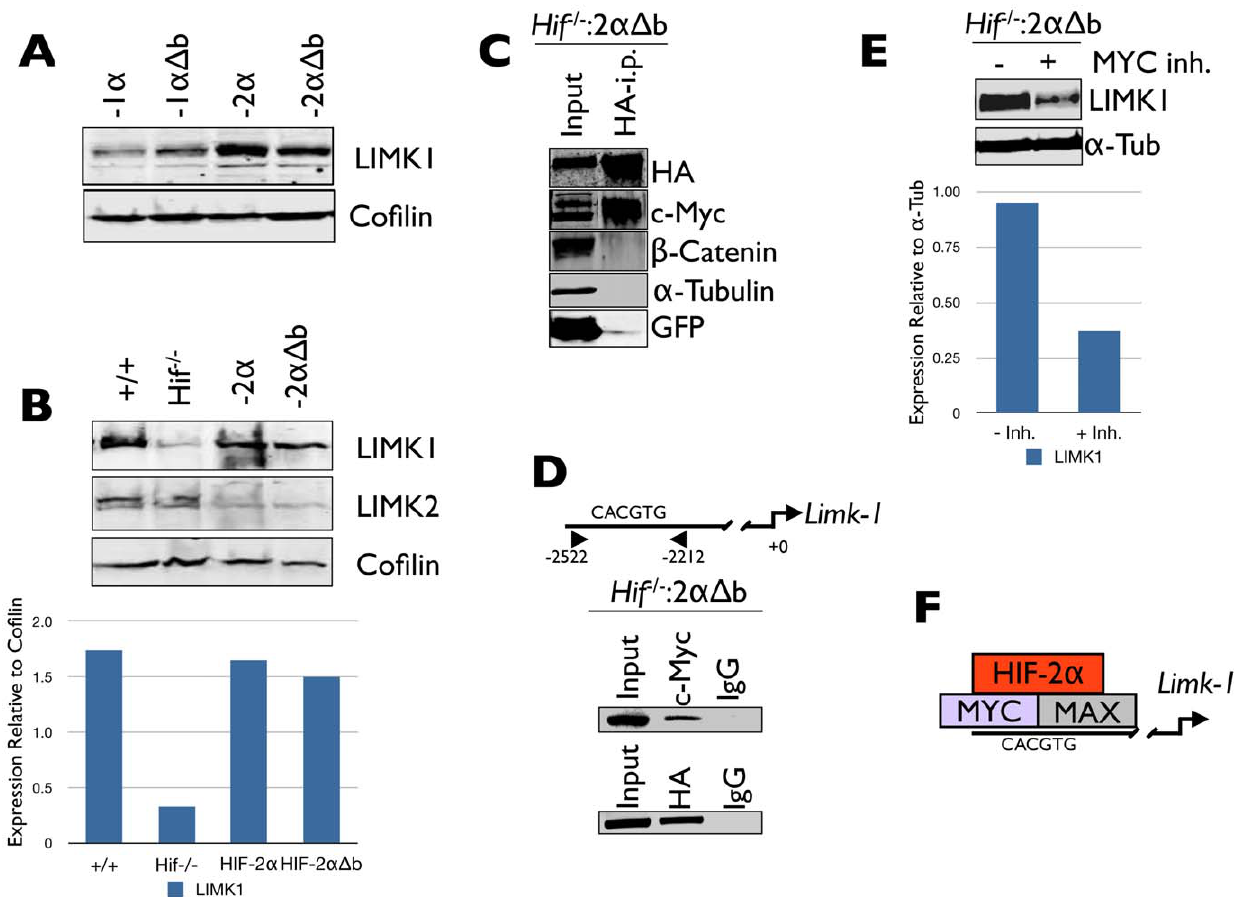
Figure 7. Canonical target gene-independent HIF-2 activity drives LIMK1 expression in TS cells via c-MYC interaction. (A) Immunoblot analysis of LIMK1 protein levels in Hif-1/2 a 2 / 2 TSCs stably reconstituted with full length HIF-1 a or -2 a , as well as versions lacking their basic domains. (B) Immunoblot analysis of LIMK1 and LIMK2 expression in control ( + ), Hif-1/2 a 2 / 2 ( Hif 2 / 2 ), and HIF-2 a and HIF-2 aD b reconstituted Hif-1/2 a 2 / 2 TSCs. Integrated densitometric analysis confirmed that both HIF-2 a , as well as HIF-2 aD b, restored LIMK1 expression to control levels in Hif-1/2 a 2 / 2 TSCs. (C) Immunoprecipitation with an anti-HA antibody of HA-tagged HIF-2 aD b followed by immunoblot with anti-HA, c-MYC, b - Catenin, a -Tubulin and GFP antibodies. (D) Schematic representation of E-box element identified within the Limk1 promoter.